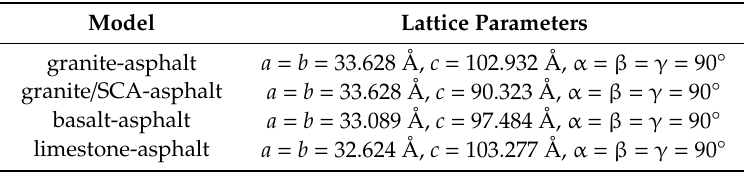
Table 2. Lattice parameters of the aggregate-asphalt